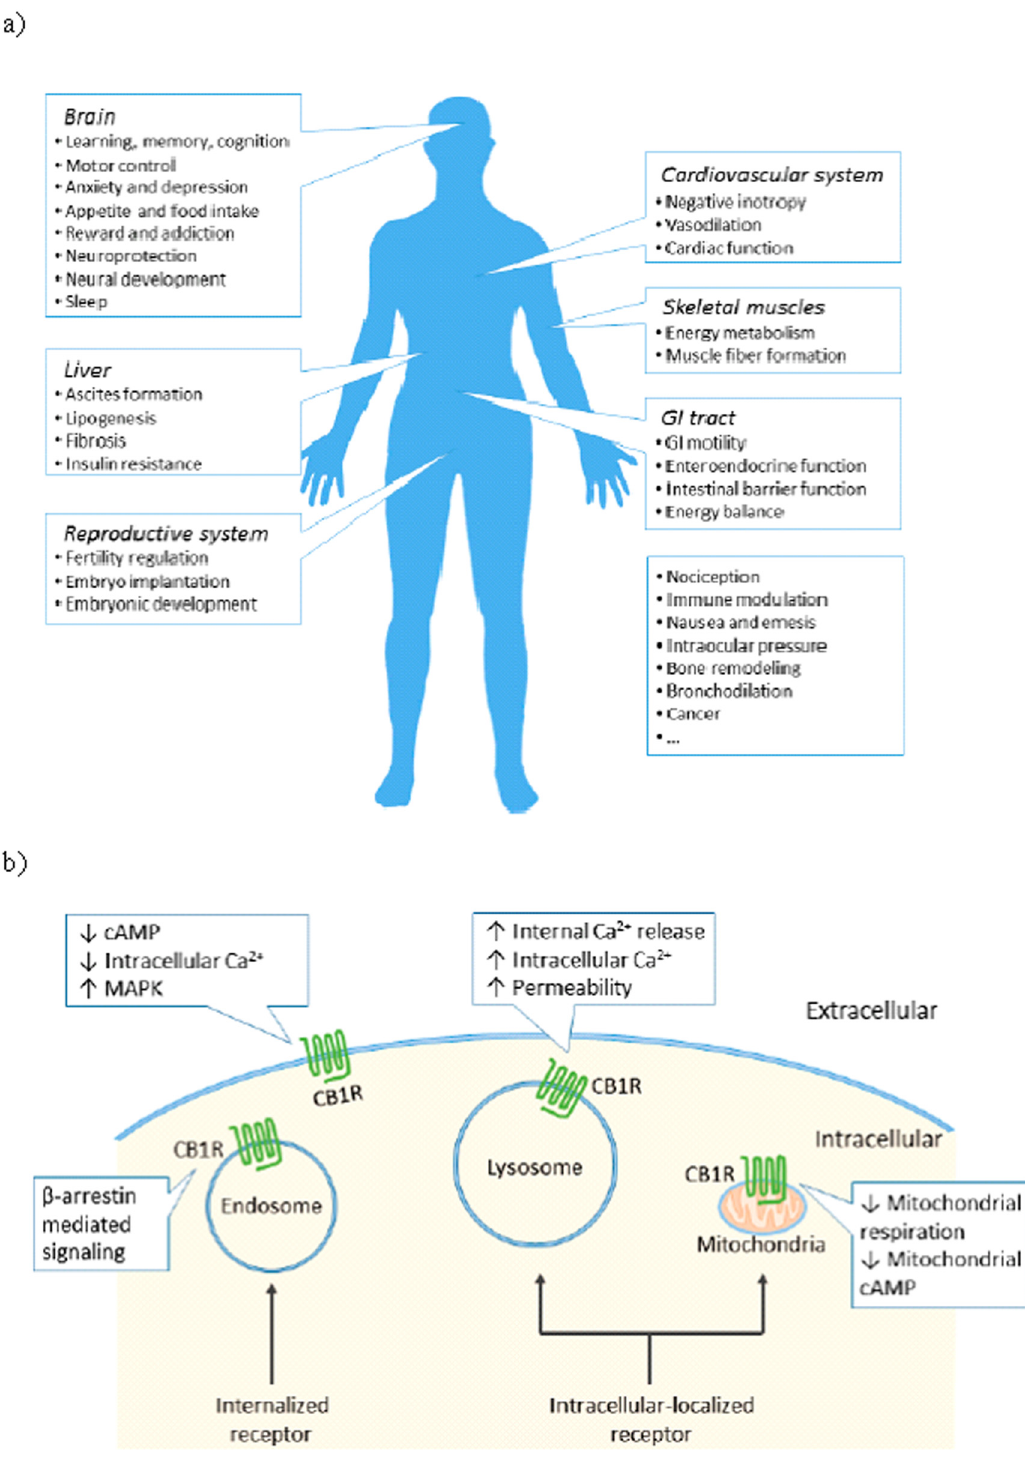
Figure 3: ( a ) The main localization sites and related functions of the CB1R in the human body; ( b ) subcellular localization of the CB1R [ 335 ]